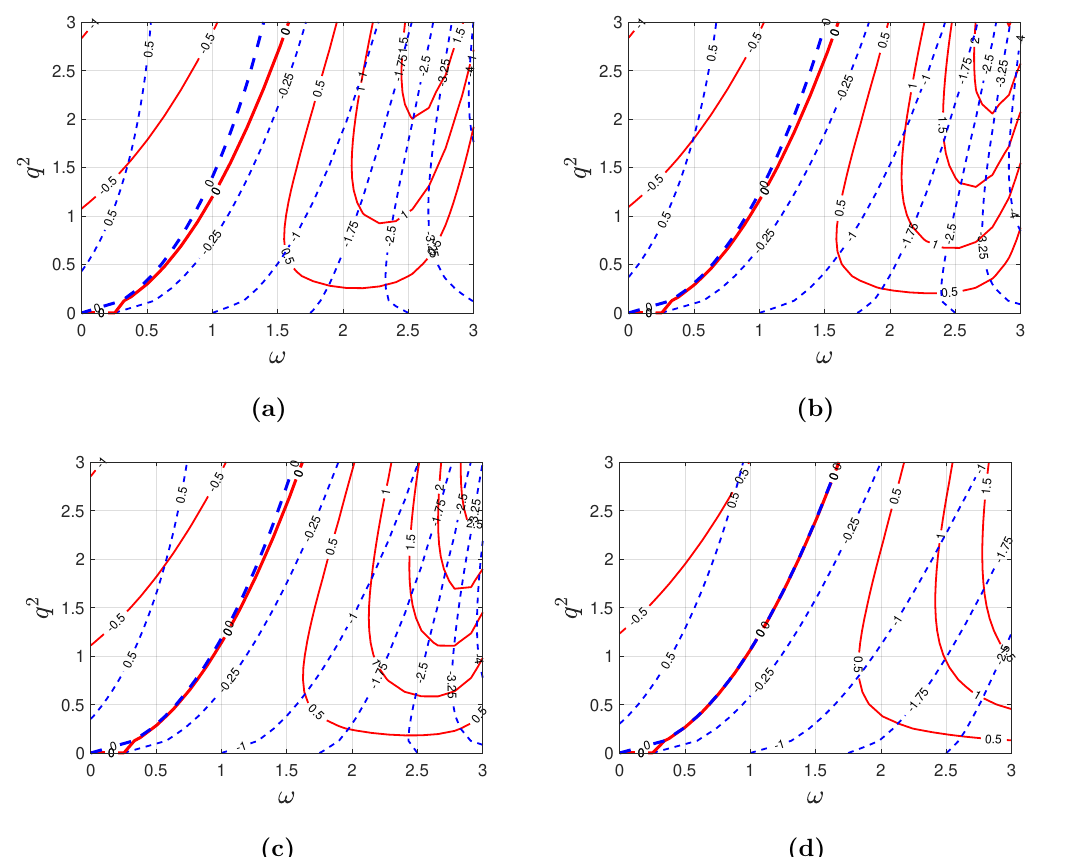
Figure 13. Contour plots for the functions (cid:30) R (blue dashed) and (cid:30) I (red solid) at (a) (cid:20) B = 0 : 25, (b) (cid:20) B = 0 : 30, (c) (cid:20) B = 0 : 33, (d) (cid:20) B = 0 :